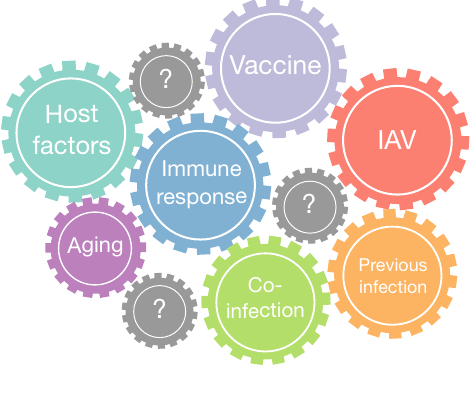
Figure 9. Main challenges in IAV infection. IAV infections facilitate secondary bacterial infections impairing the IR deputed to the bacterial clearance. The IAV infection is controlled by IR, which in turn is shaped by host genetic factors, previous infections, vaccination, and